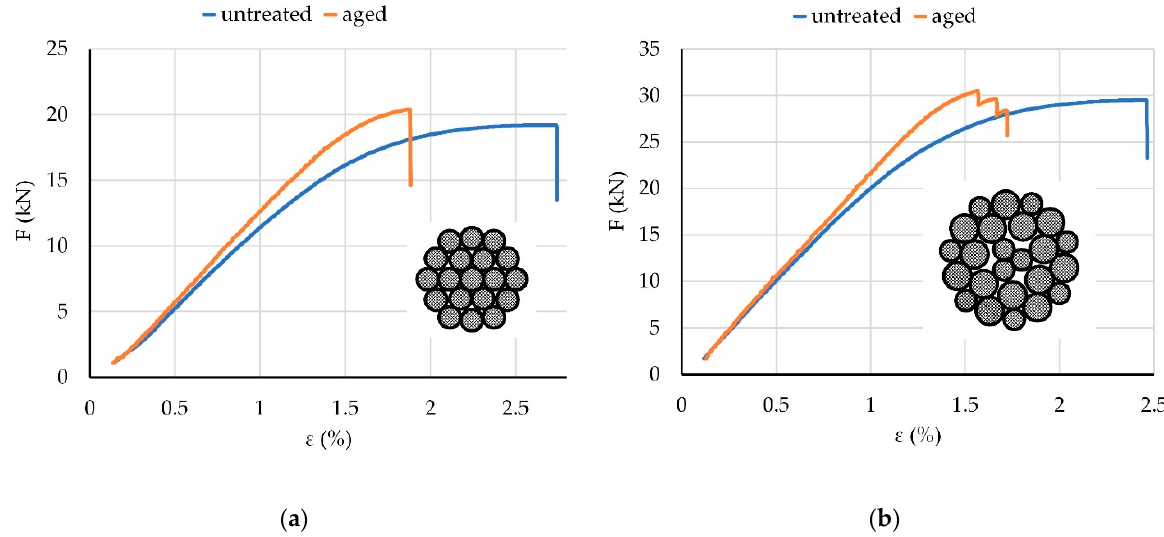
Figure 8. Typical tensile diagrams in untreated and 150 °C/45-min aged conditions of ( a ) Ø3.6C compact-type steel cord and ( b ) Ø4.5W Warrington-type steel cord.